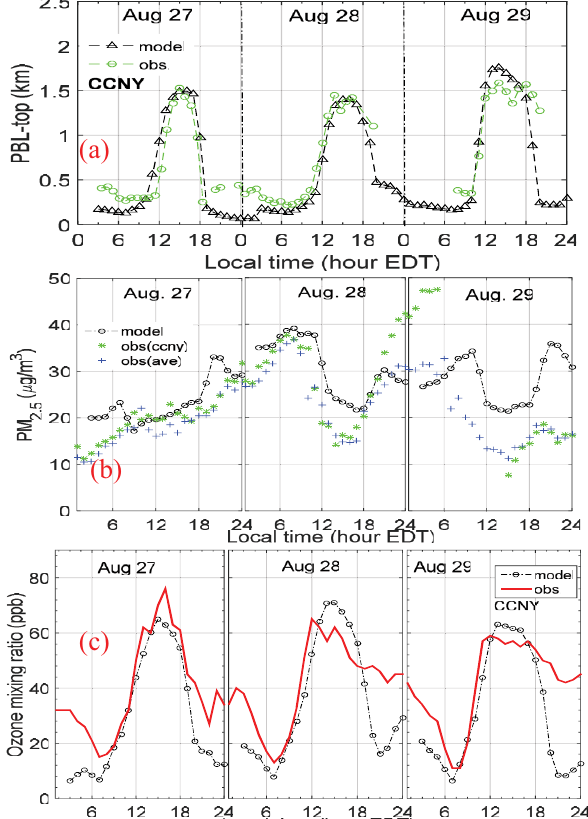
Fig.5 (a)-(c) Comparison of PBLH, PM 2.5 and O 3 between the NAM-CMAQ model and